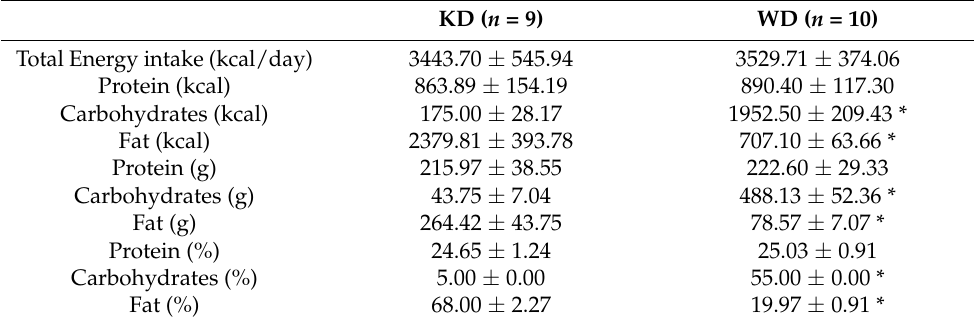
Table 2. Diet composition and macronutrients